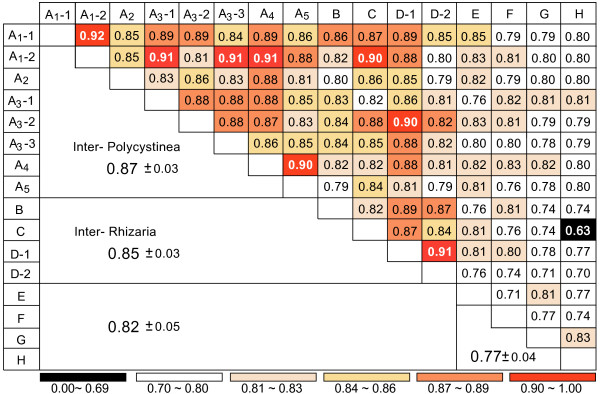
Genome similarities between single-celled organisms measured by the pattern similarity score (PaSS). Alphabetical letters represent the species described in Table 1. The area to the right of the diagonal accommodates PaSS values between a pair of species (for an exact match, PaSS = 1), while the area to the left of the diagonal contains the mean of the PaSS values located in the area.